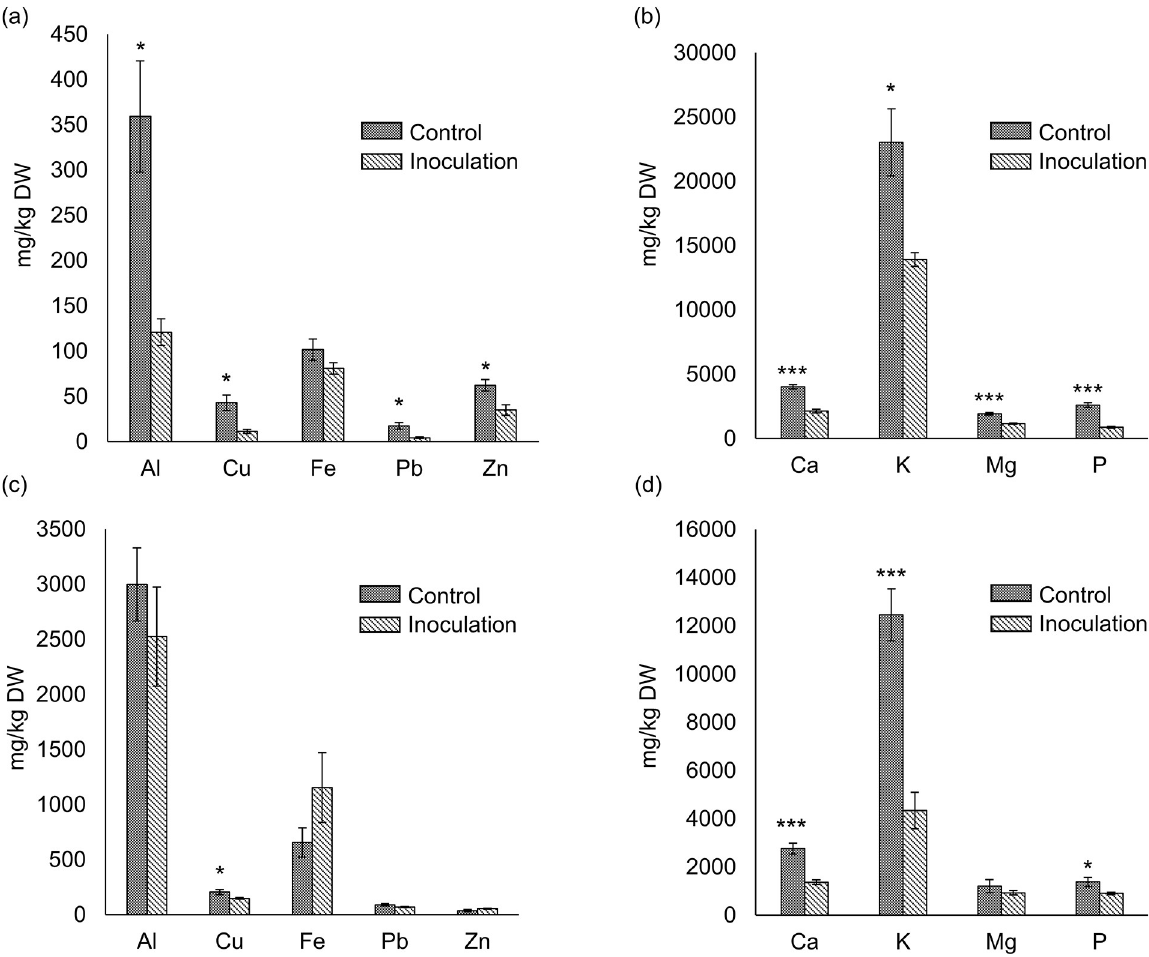
Fig 4. Concentrations of elements in Miscanthus sinensis seedlings in the inoculation test. (a) Concentrations of Al and heavy metals in the aboveground parts, and (b) concentrations of inorganic elements in the aboveground parts. (c) Concentrations of Al and heavy metals in the roots, and (d) concentrations of inorganic elements in the roots. Differences between seedlings inoculated with C . cupreum and control seedlings were evaluated using Student’s t -test. Results are expressed as means ± SE (n = 5). ��� , P < 0.001; � , P < 0.05.